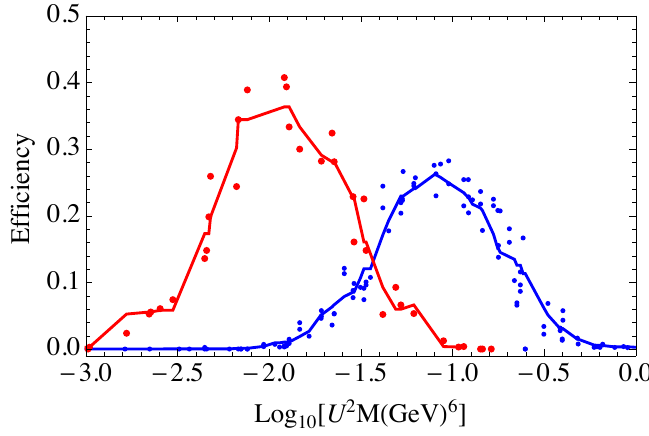
Figure 8 . Acceptance of the cuts in eqs. (3.20) in blue and (3.21) in red as a function of the combination U 2 M 6